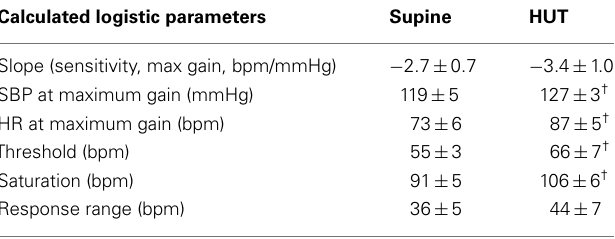
Table 3 | Calculated cardiovagal baroreflex sensitivity (slopes), threshold, saturation, and response range using the modified Oxford method.